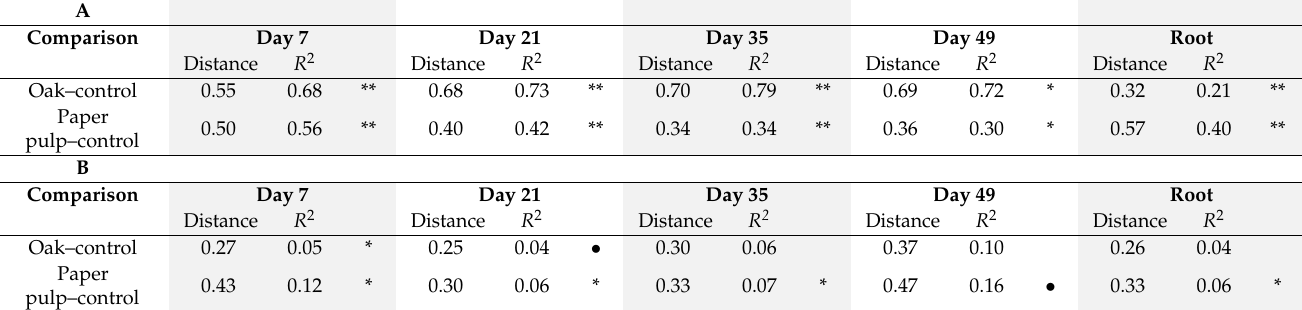
Table 2. Effect of paper pulp and oak amendment over time on fungal (A) and bacterial (B) community composition, relative to the control soil and roots. For each comparison, the Bray–Curtis dissimilarity distance between group centroids is indicated (Distance), as well as the proportion of variance explained by soil amendment (R2) and its significance (pairwise ADONIS, FDR-adjusted p -values: ** p < 0.01, * 0.01 < p < 0.05, • 0.05 < p <